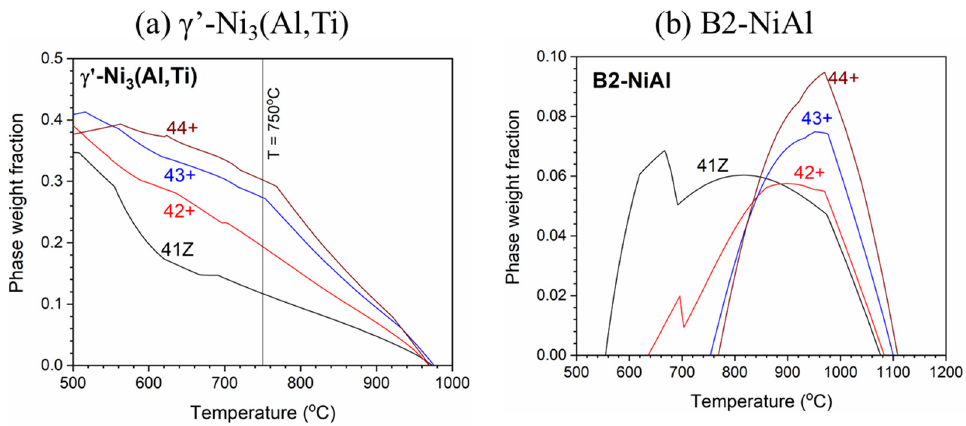
Figure 1. Thermodynamic phase stability of ( a ) γ ’-Ni 3 (Al,Ti) and ( b ) B2-NiAl phase for the model alloys.